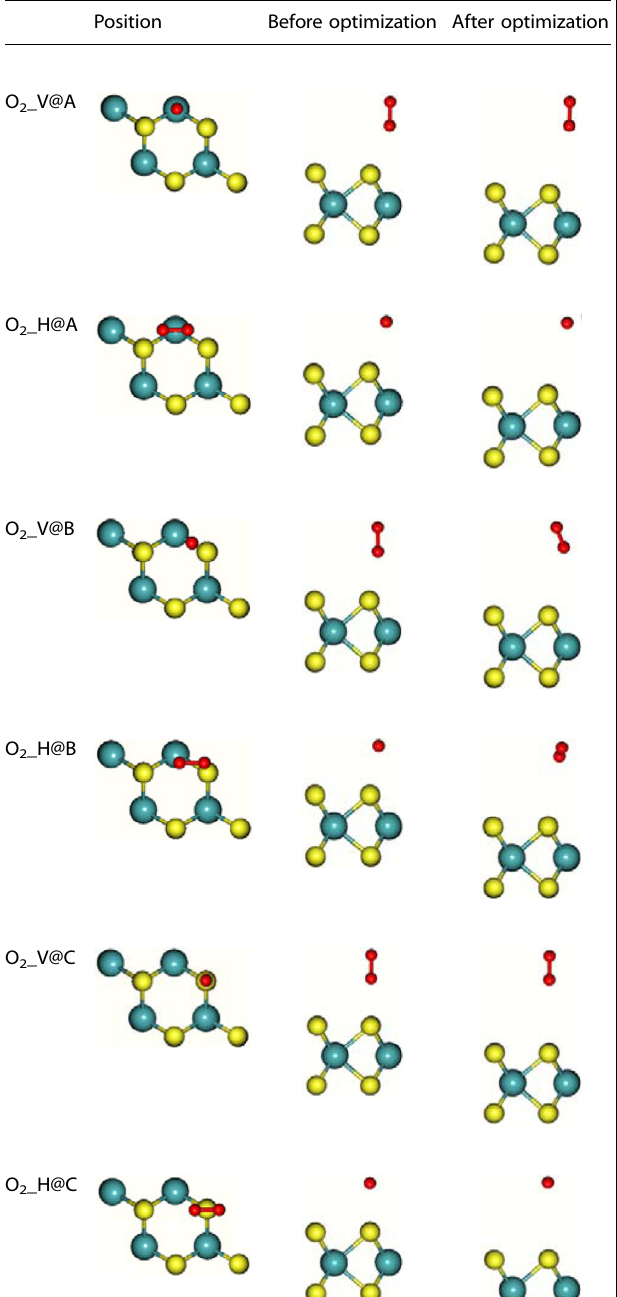
Table 2. Fully relaxed distances for the oxygen (O 2 ) on top of MoS 2 monolayer in different positions. Position Before optimization After